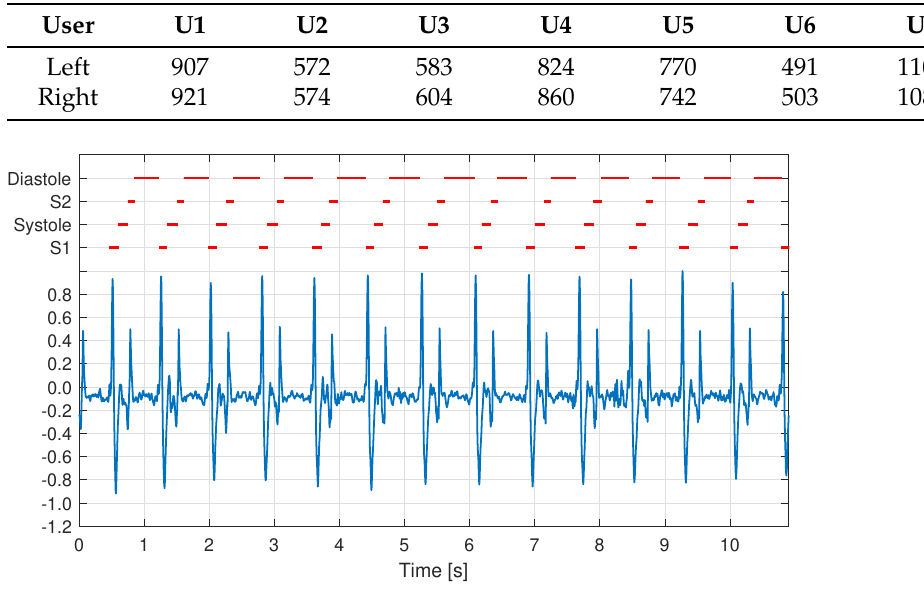
Figure 7. Example of the segmentation of S1, systole, S2, and diastole episodes of the carotid sounds applied to a signal acquired from user U1. The operation is based on the segmentation function for phonocardiogram recordings presented in